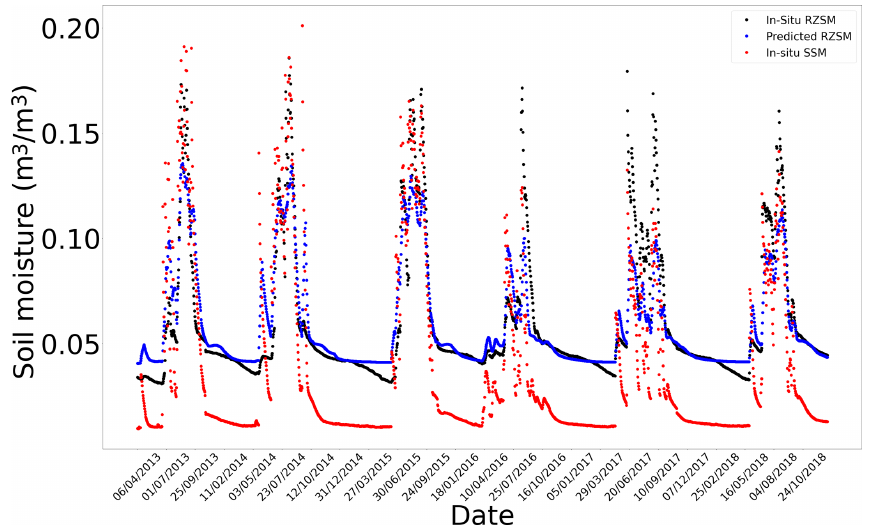
Figure E9. In situ SSM, in situ RZSM, and predicted RZSM series at station Wankama (AMMA-CATCH) with model ANN_SSM.